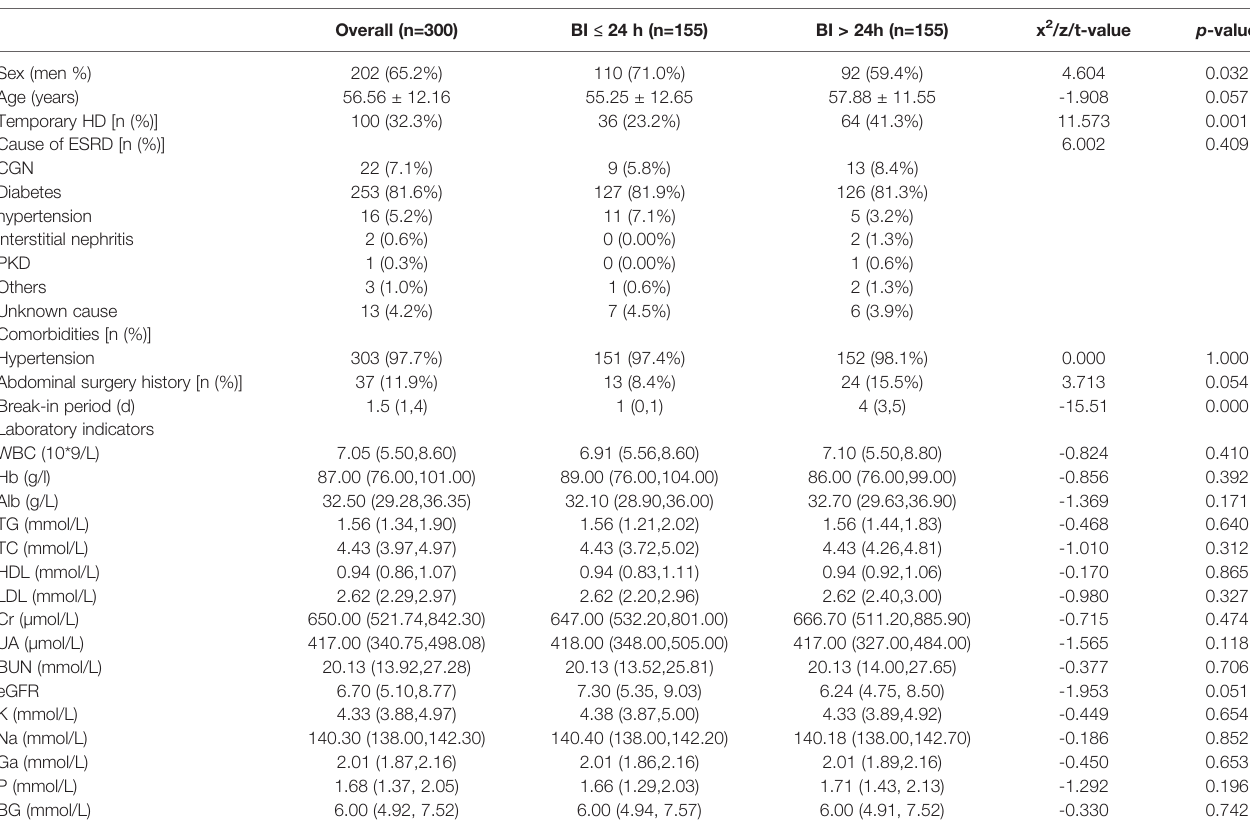
TABLE 1 | Baseline characteristics of patients in different BI groups.